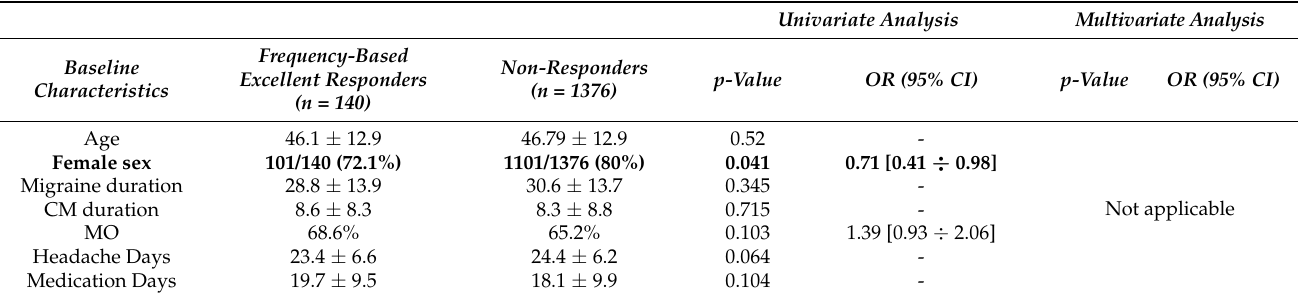
Table 3. Comparison between frequency-based excellent responders and non-responders during the third onabotulinumtoxinA cycle. Univariate Analysis Multivariate